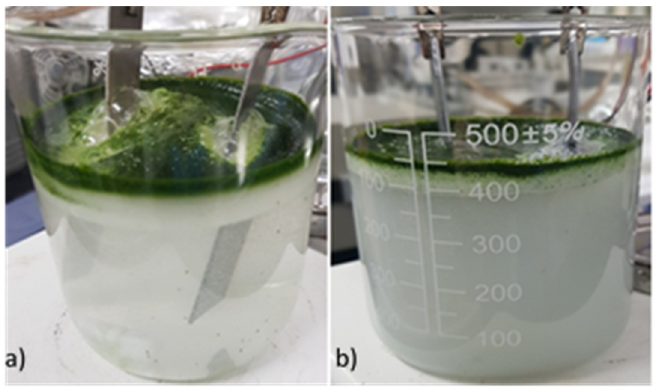
Figure 3. Comparison in visibility of the supernatant after electrocoagulation with (a) Mg and (b) Pb electrodes.